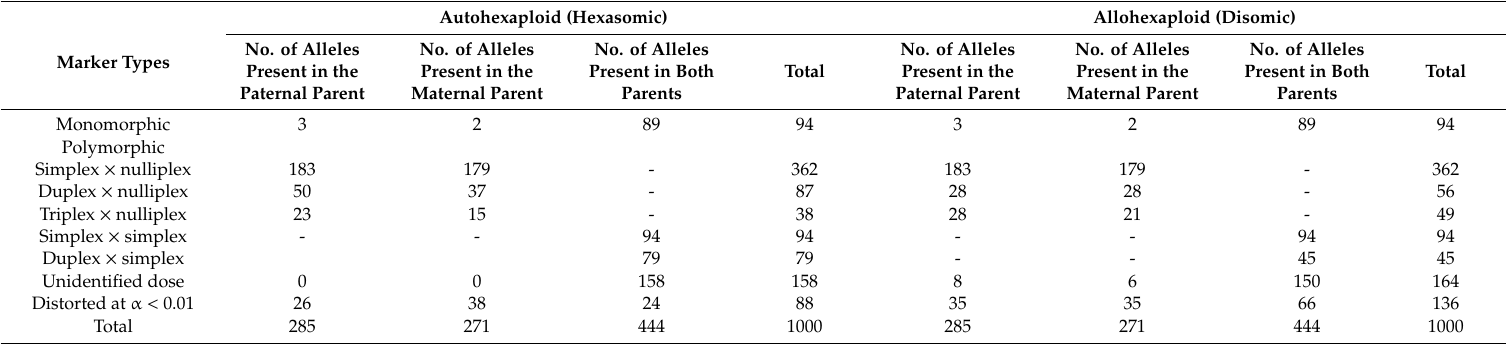
Table 1. Classification of 1000 alleles detected in 223 expressed sequence tag–simple sequence repeat (EST-SSR) loci using the χ 2 goodness of fit test ( α = 0.01, df = 1) depending on the segregation ratios of hexasomic and disomic